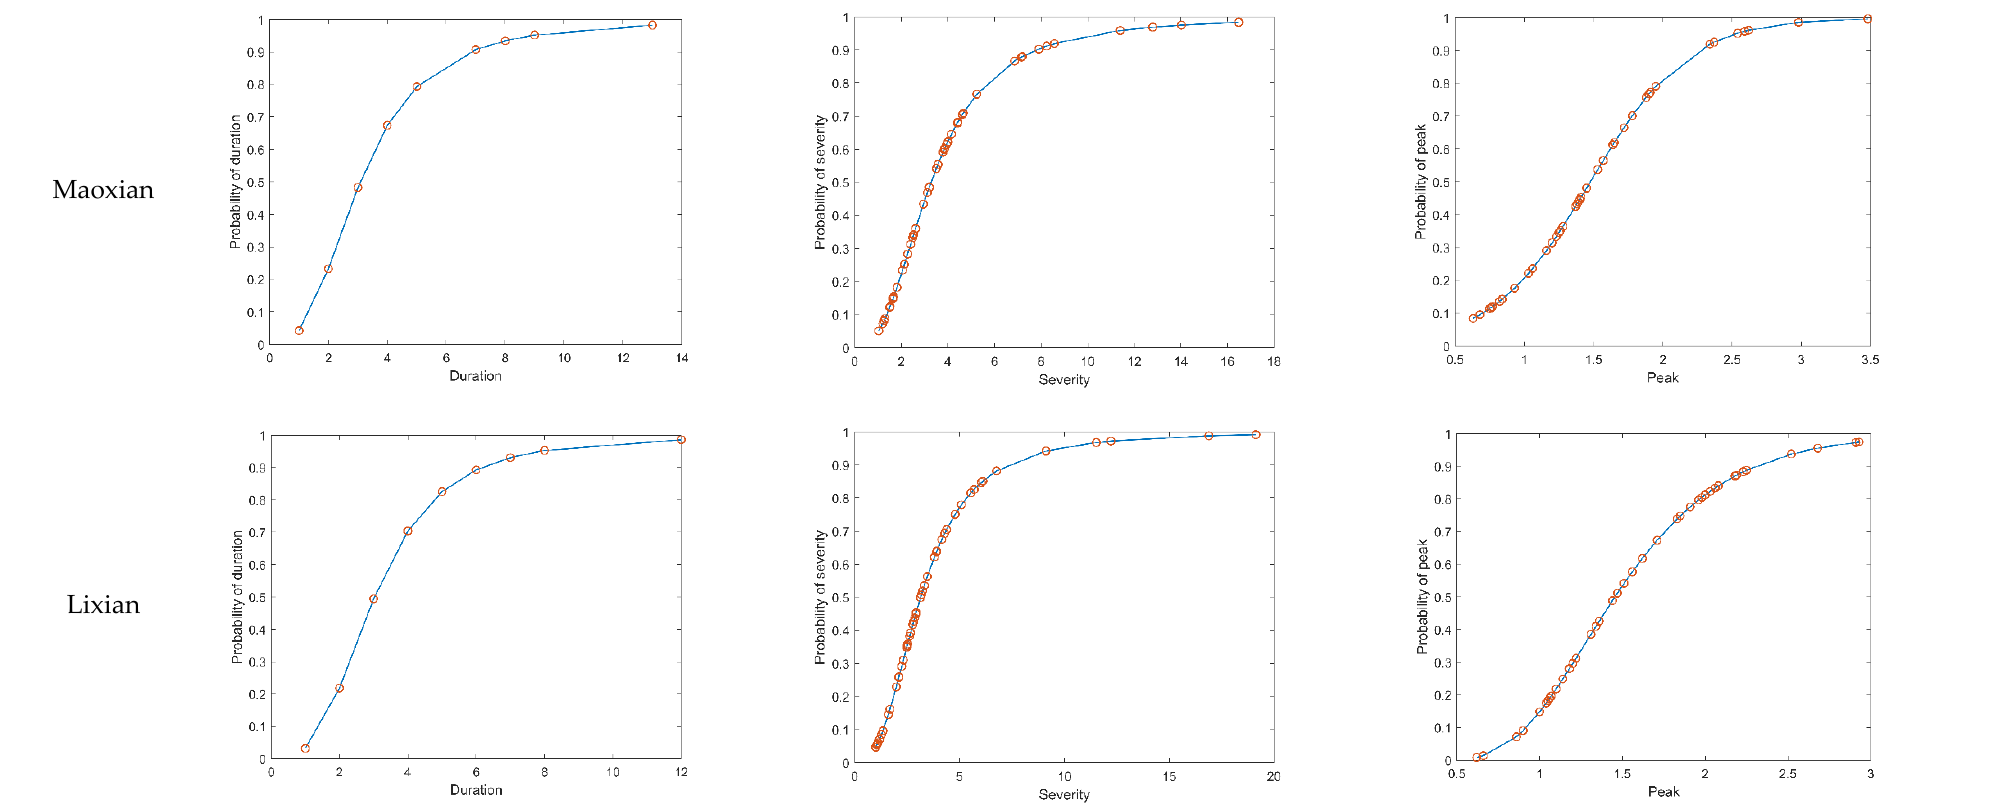
Figure 5. Univariate cumulative probability distribution of drought characteristics.